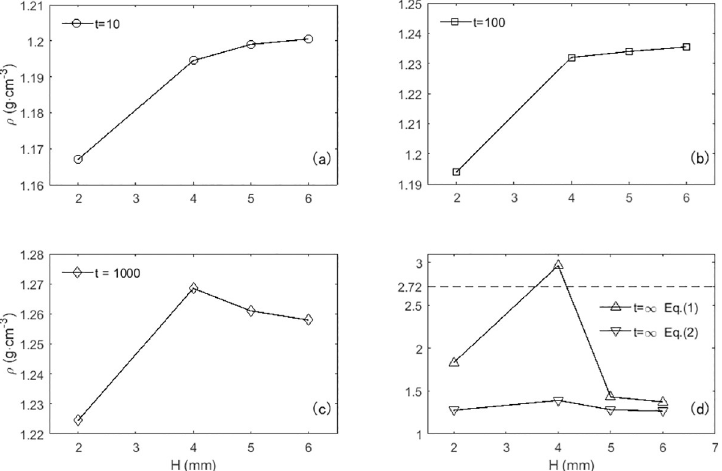
Fig 5. The dependence of the overall packing density on the drop height. Drop times: t = 10 (a), t = 100 (b), t = 1000 (c) and t = 1 (d). The estimations of steady state ( t = 1 ) are obtained from the fits to the inverse-logarithmic function ( 4 ) and the stretched exponential function ( 5 ). The dotted line in the panel (d) represents the relative density of soil. https://doi.org/10.1371/journal.pone.0250076.g005 The empirical inverse logarithmic formula [17] and the stretched exponential function [19] have been verified to be feasible and effective to represent the temporal evolution of the pack- ing fraction of mono-disperse glass spheres under vertical tapping. The packing density mea- surements of poly-disperse soil here are analyzed separately through curve fitting to the two formulas (Fig 4):